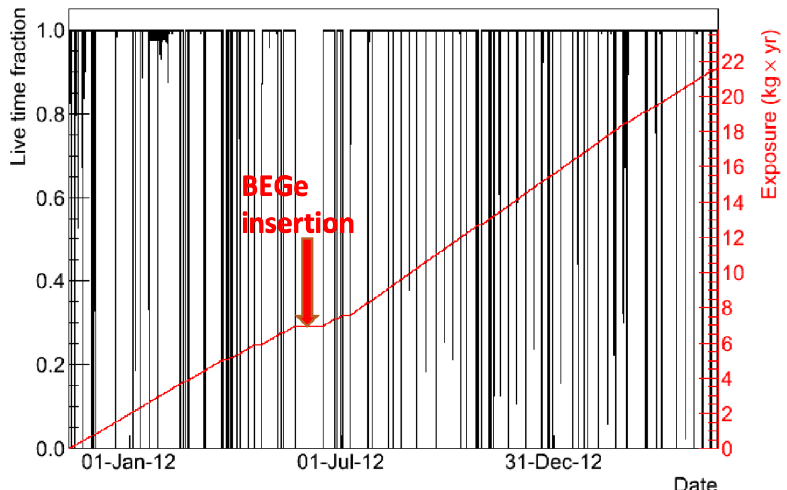
Figure 7. The evolution of the Phase I